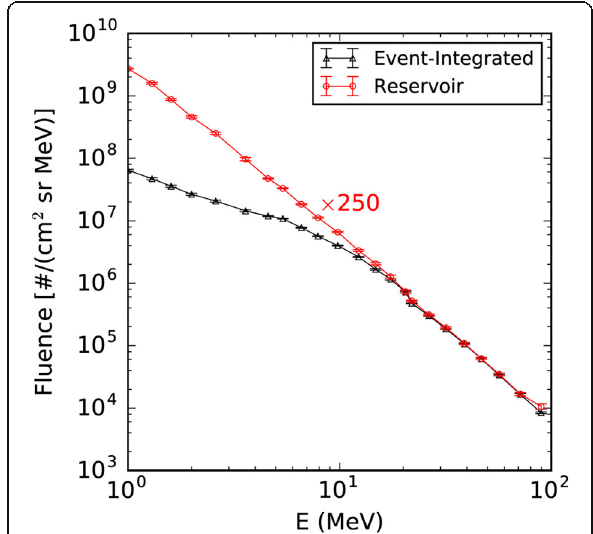
Fig. 27 Event integrated and reservoir spectra during the 11/22/ 1977 SEP event. The spectrum shows a double power-law feature, while the reservoir spectrum exhibits a single power law (from Zhao et al. 2017). This effect was interpreted in terms of particle streaming and rigidity-dependent scattering effects that modify the spectrum at lower